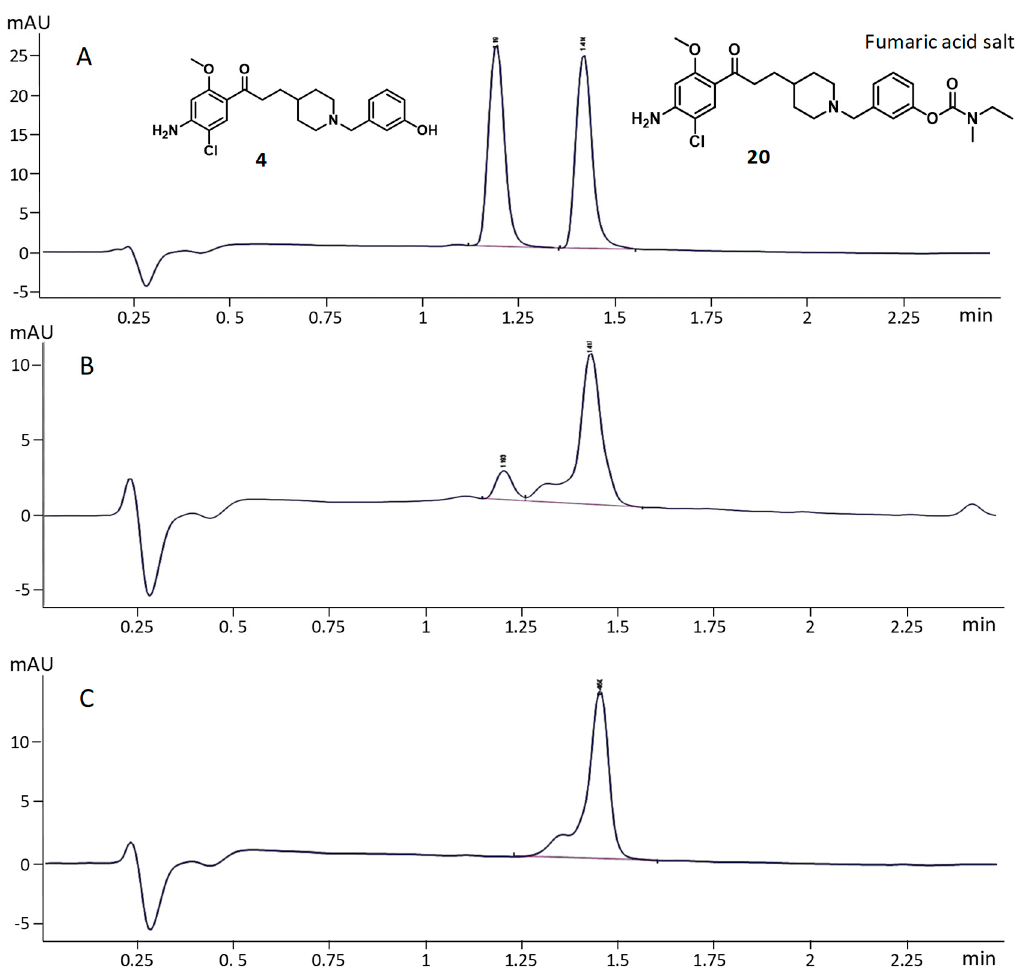
Figure 6. Decarbamoylation of 20 by ( ee )AChE; ( A ): 20 (5 µM) and 4 (5 µM) without ( ee )AChE; ( B ): 20 (5 µM) in the presence of 250 U/mL ( ee )AChE ( C ): 20 (5 µM) without ( ee )AChE (negative control); .